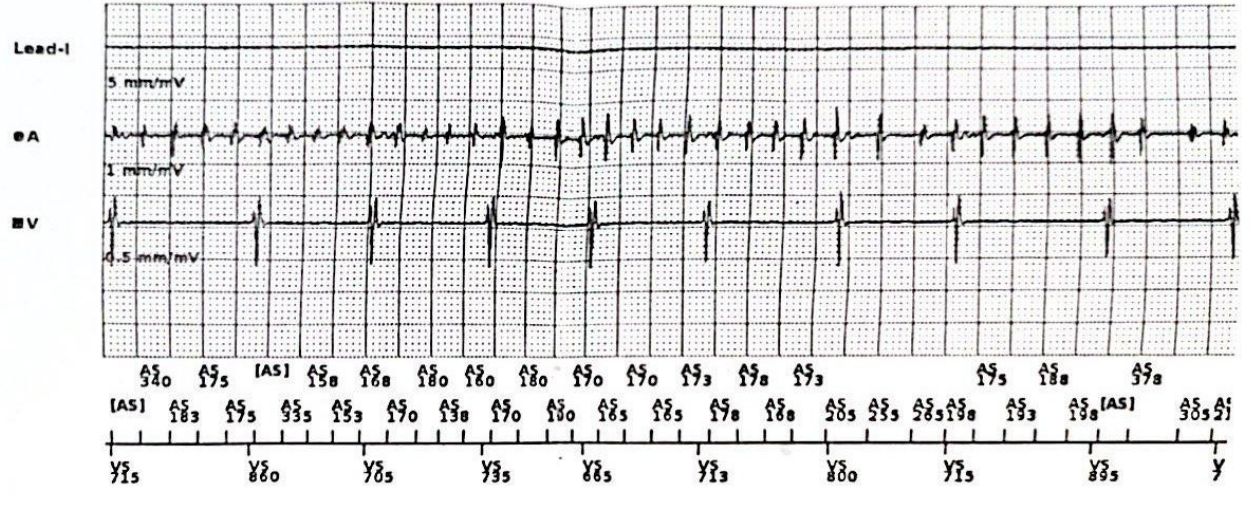
Figure 5. Atrial high-rate episode recorded by the pacemaker registry.